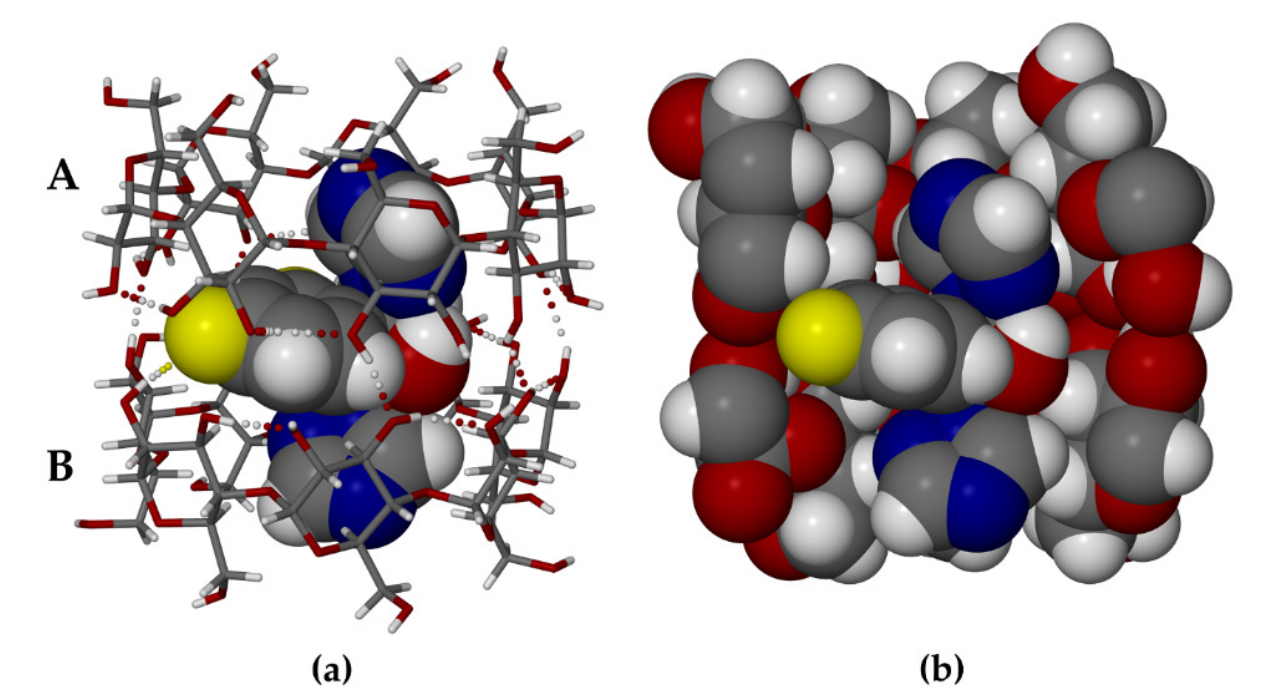
Figure 3. The dimeric complex TBCDFLU: ( a ) the two independent host molecules A and B shown in stick representation with the guest molecule FLU drawn in space-filling mode; ( b ) from the same viewpoint, a cutaway image with host and guest molecules in space-filling style.